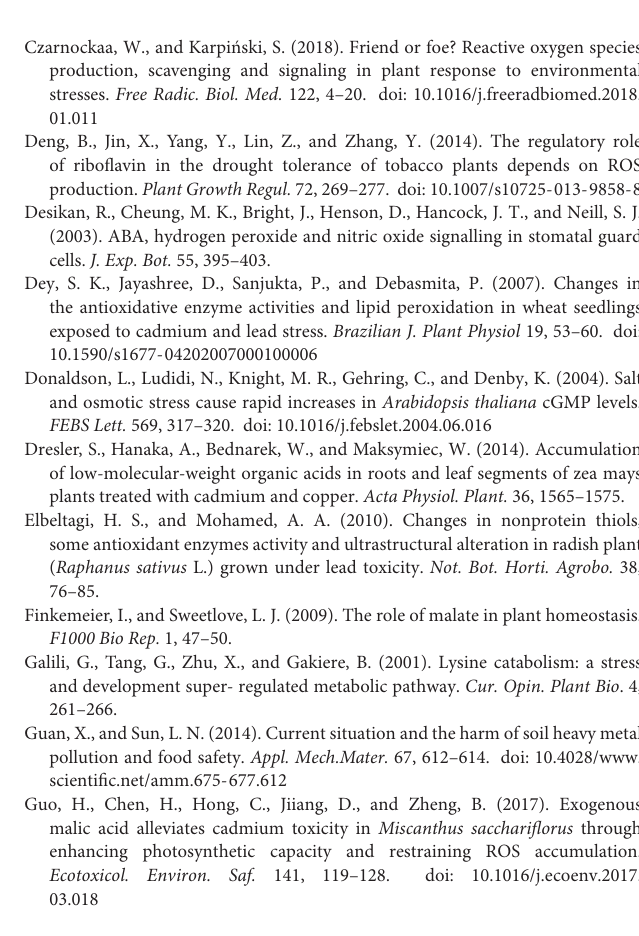
Supplementary Figure 1 | Quality control sample evaluation: the score plot of the PCA model. Huidan No. 4 lead-free treatment (1), Huidan No. 4 exposed to lead (2), Ludan No. 8 lead-free treatment (3), and Ludan No. 8 exposed to lead (4). Supplementary Figure 2 | Heatmap analysis of metabolic profiles in roots of Huidan No. 4 exposed to lead and lead-free treatment. Huidan No. 4 lead-free treatment (HCK), Huidan No. 4 exposed to lead (H300). Supplementary Figure 3 | Heatmap analysis of metabolic profiles in roots of Ludan No. 8 exposed to lead and lead-free treatment. Ludan No. 8 lead-free treatment (LCK), Ludan No. 8 exposed to lead